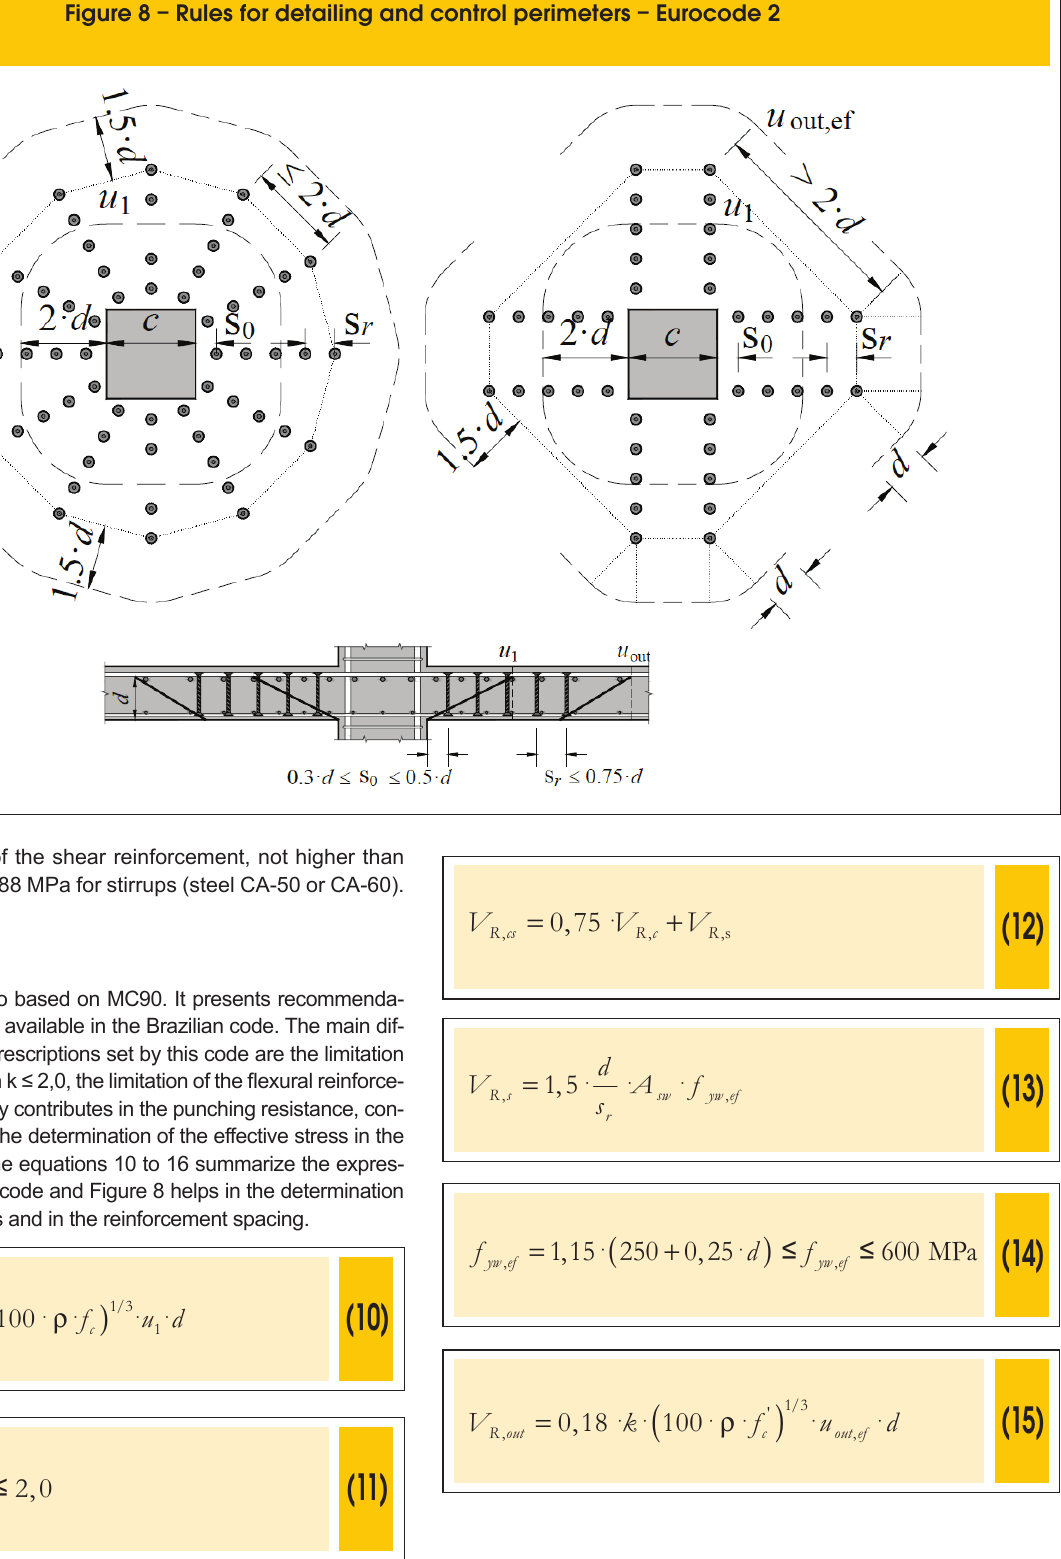
Figure 8 – Rules for detailing and control perimeters – Eurocode